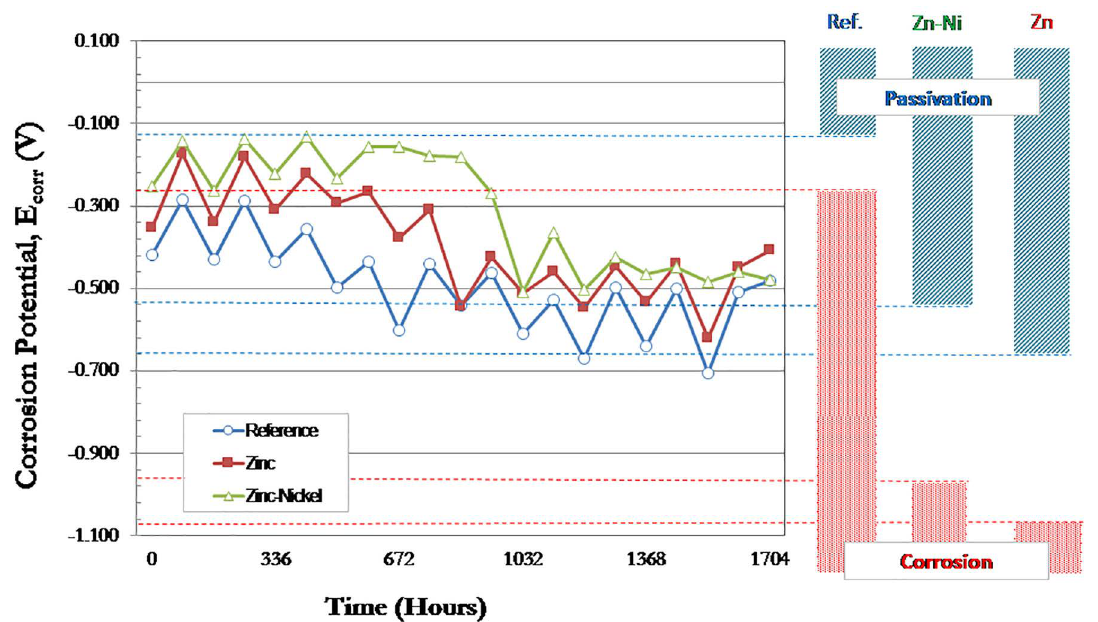
In the salt spray exposure test, the parameters cited before (temperature, humidity, saturation level) are kept constant, measurements, as can be seen in Figure 7.